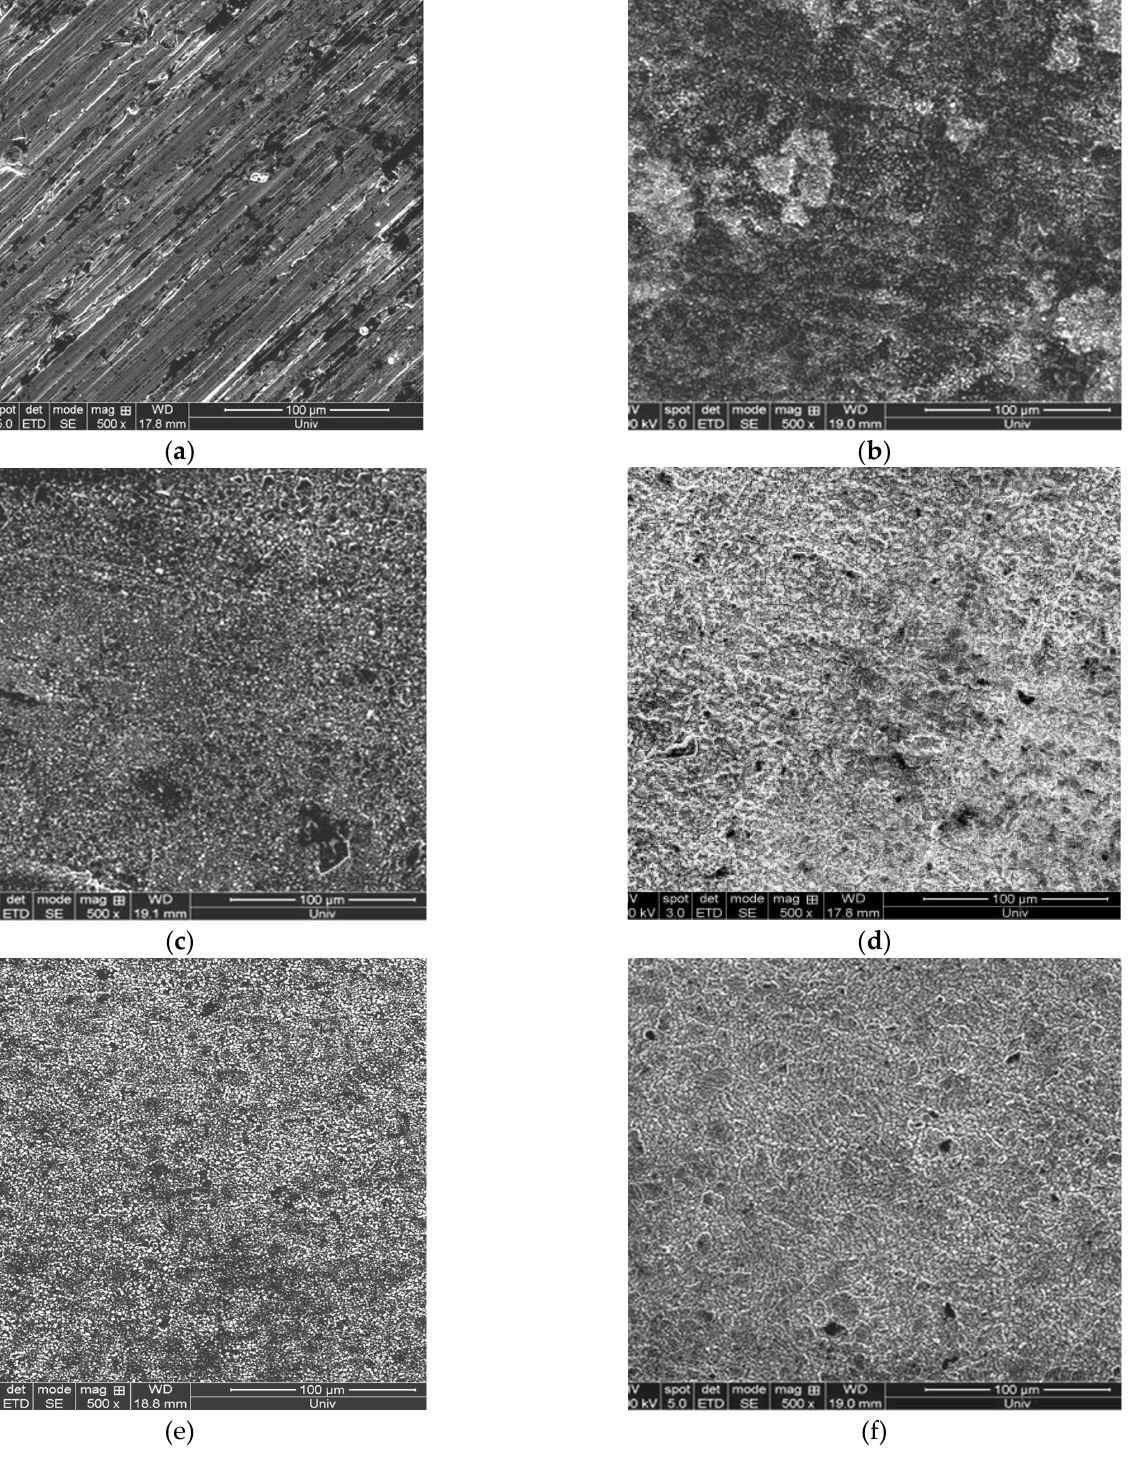
Figure 9. Surface morphology of vanadium deposition layer at different current densities and substrates: ( a ) matrix, ( b ) 90 mA·cm −2 , ( c ) 120 mA·cm −2 , ( d )150 mA·cm −2 , ( e ) 200 mA·cm −2 , and ( f ) 250 mA·cm −2 .